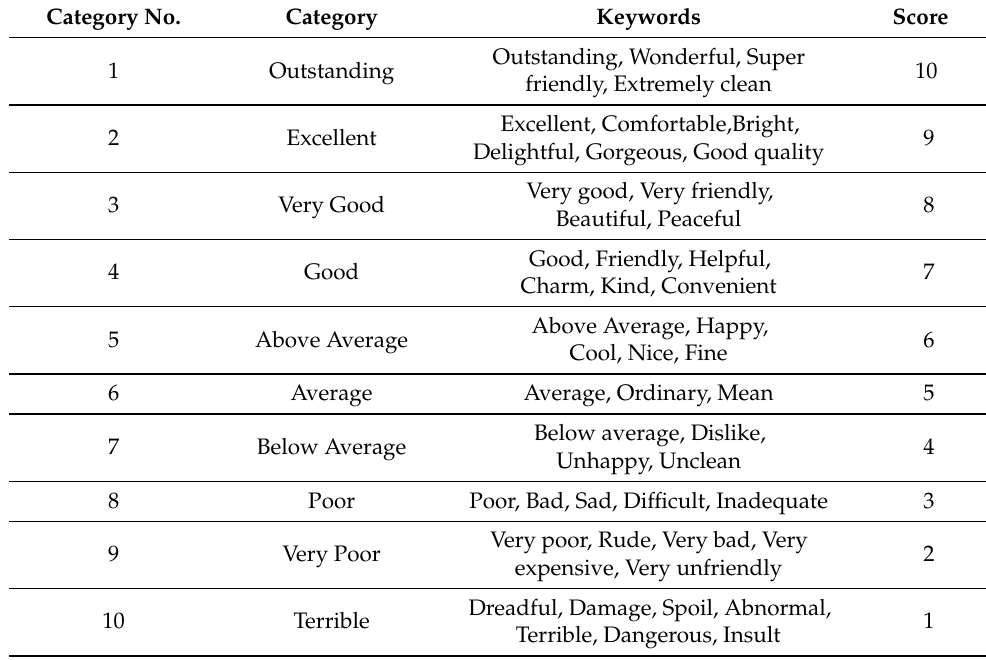
Table 6. Example of Keywords of different Categories.